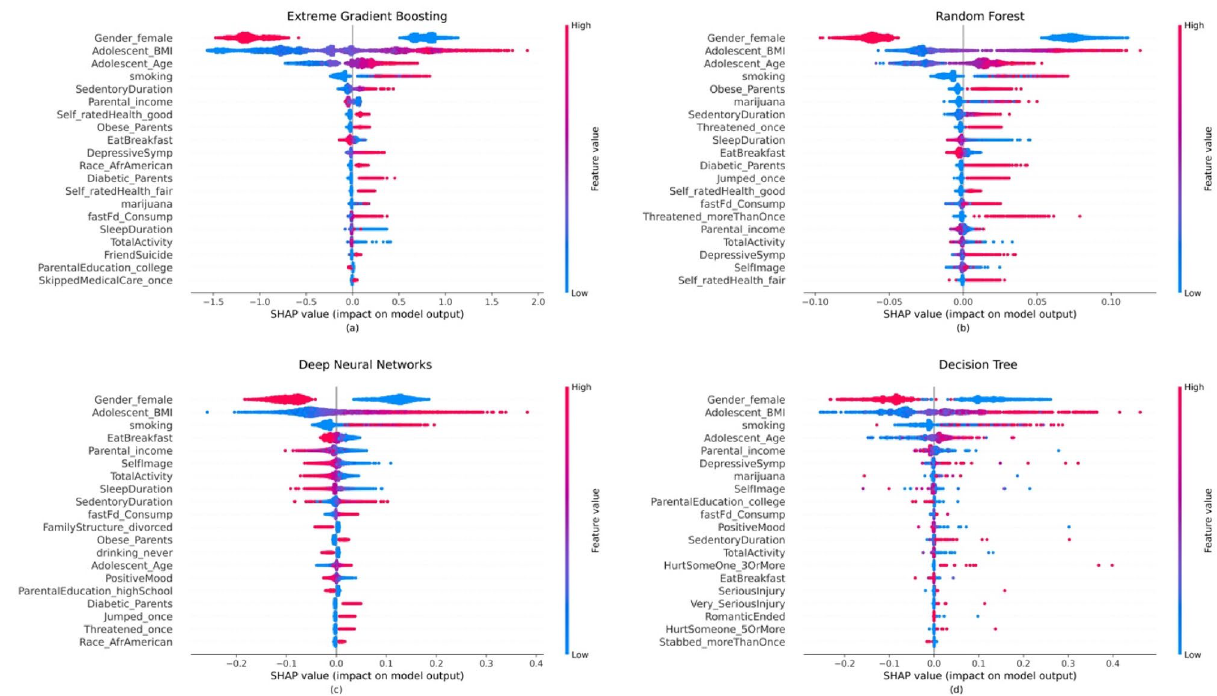
Figure 6. Global interpretation of ML models—SHAP summary plots of the input features. Features were sorted in descending order by SHAP values. SHAP values for each feature were calculated, which is represented by a single dot. Dots were colored based on the underlying feature’s value. For the features of gender_female, the red dots indicated female and the blue dots indicated male. The summary plot is created for each ML model: ( a ) XGBoost, ( b ) RF, ( c ) DNN, ( d )